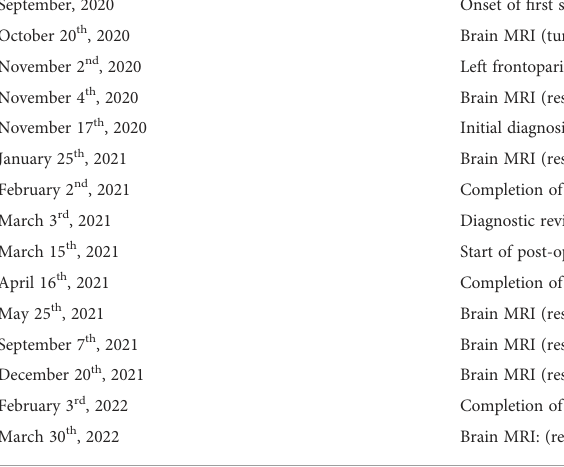
MRI, magnetic resonance imaging; AT/RT, atypical teratoid/rhabdoid